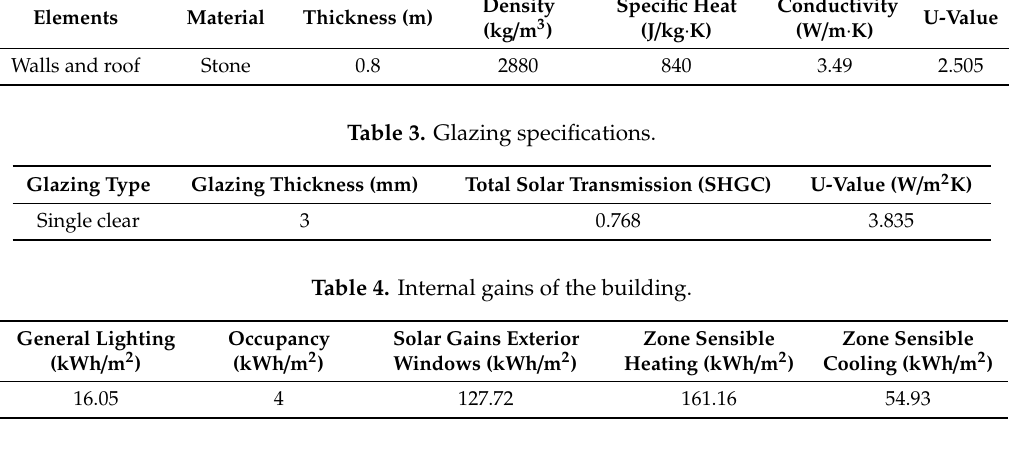
Table 4. Internal gains of the building.